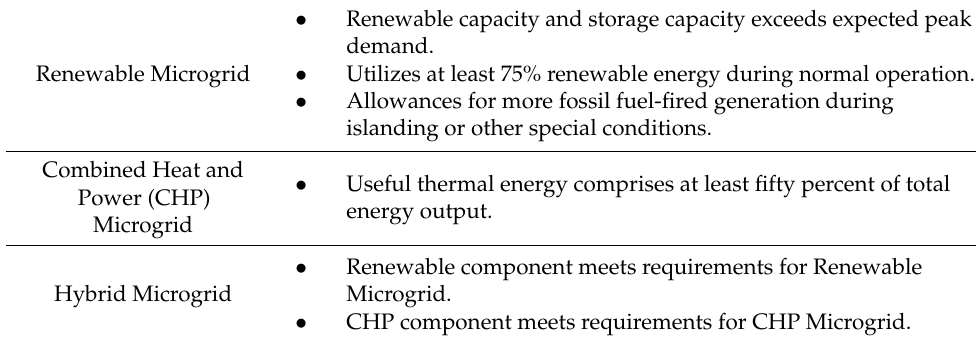
Table 3. Microgrid categories under Puerto Rico Regulation